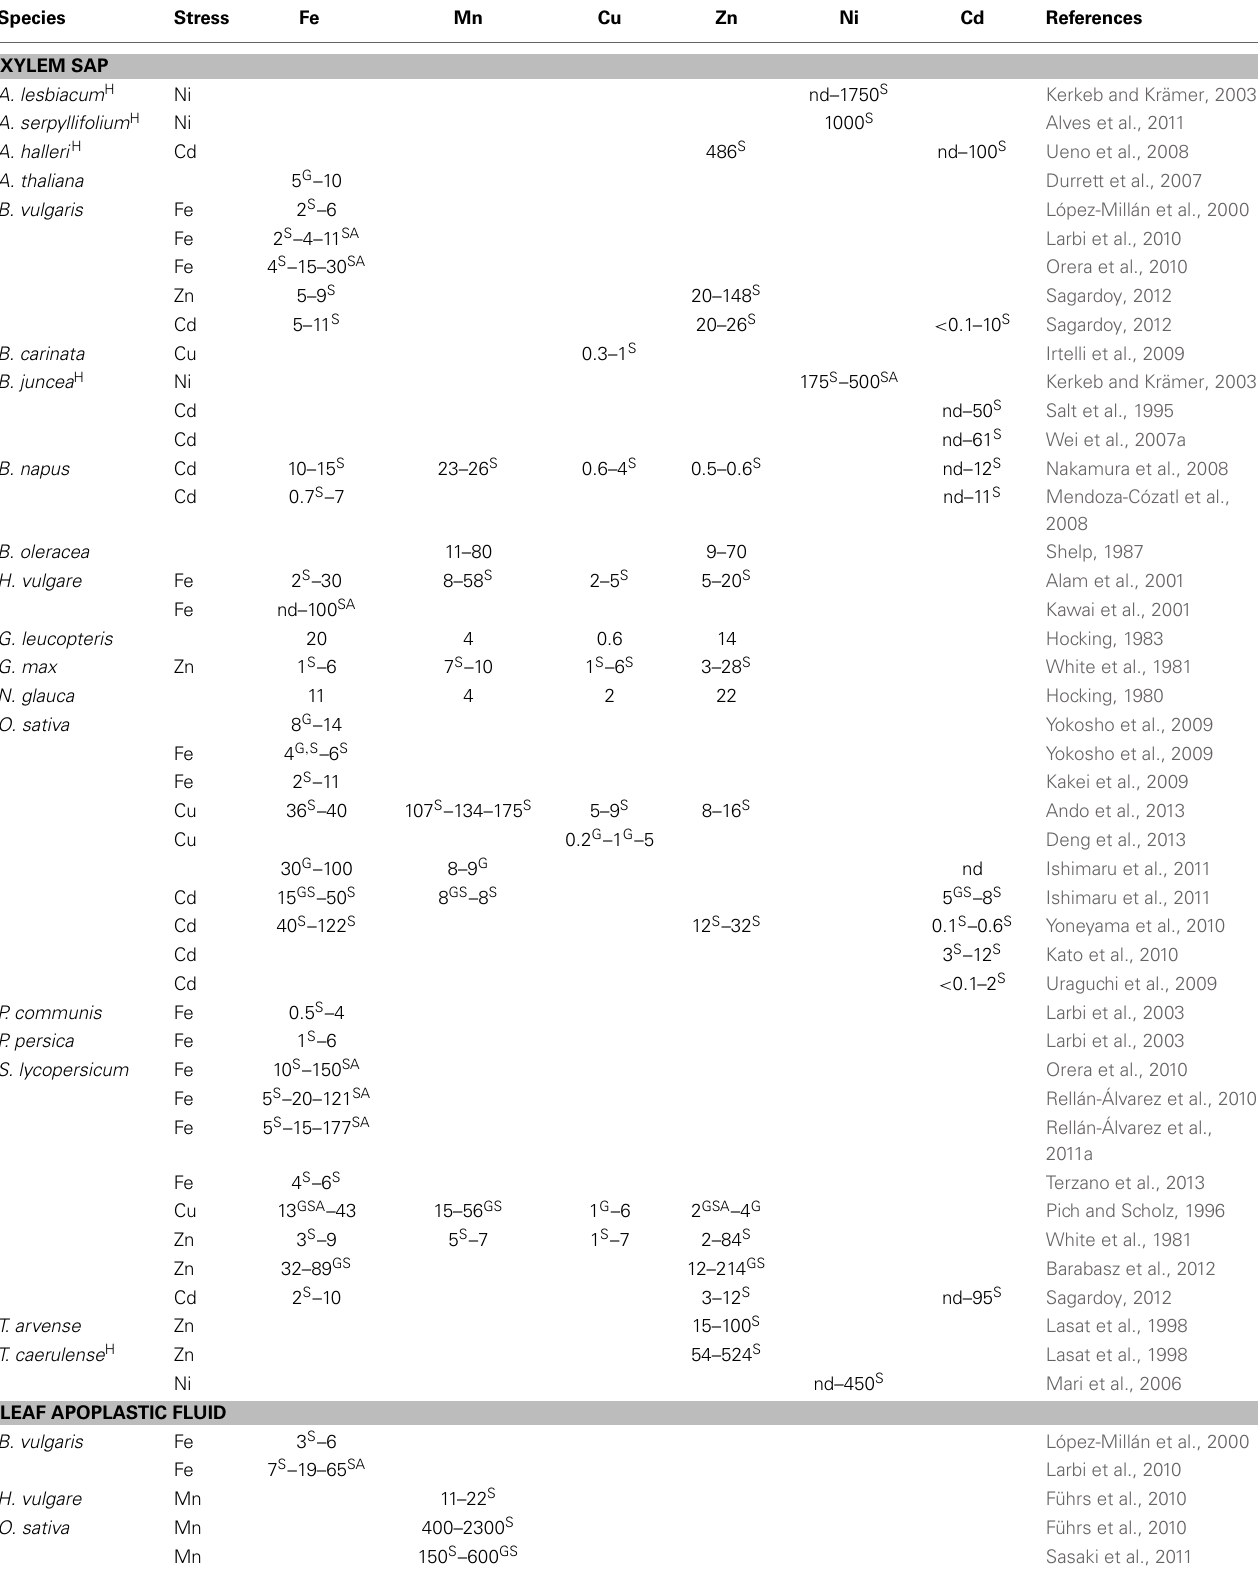
Table 1 | Metal concentrations (in μ M) in xylem sap, leaf apoplastic fluid and phloem sap in different plant species.